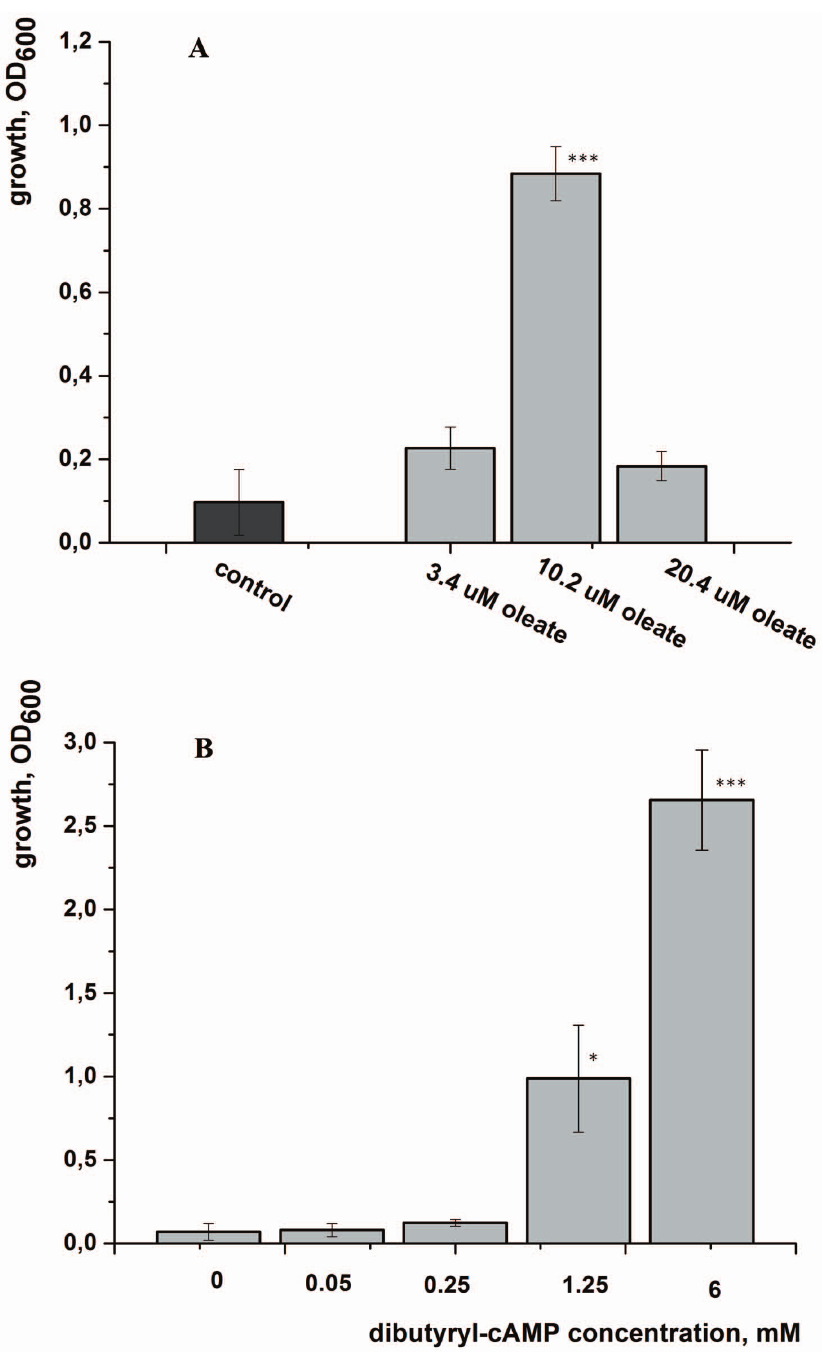
Figure 6. Fatty acid- and dibutyryl-cAMP-induced resuscitation ofM.tuberculosis NC cells. NC cells were obtained inoculated to an initial OD 600 =0.2 and resuscitated in batch format. The OD 600 was measured after resuscitation for 20 d (A) or 25 d (B). This experiment was repeated two times with similar results; the error bars represent the standard error of the mean. Asterisks indicate that the results are significantly different from the control by Student’s t-test.